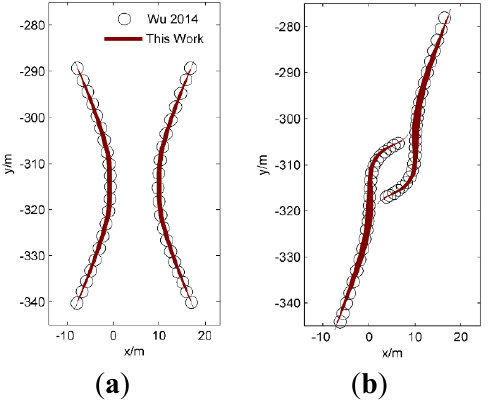
Figure 6. Two initiation fractures in ( a ) a horizontal wellbore and ( b ) two horizontal wellbores. Blue lines represent horizontal wellbores, and red lines represent initial fractures.